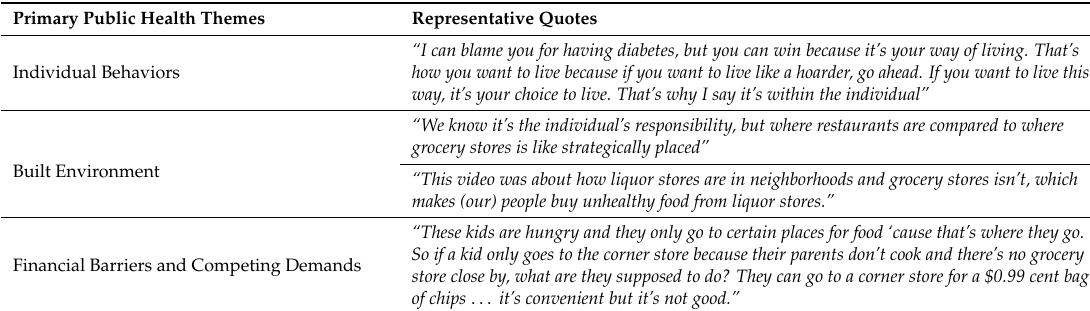
Table 2. Prominent Themes Emerging from Responses to Individual Questionnaires and Group Discussion and Illustrative Participant